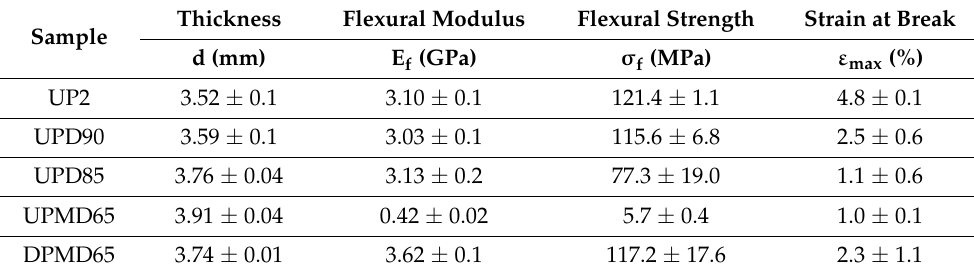
Table 13. Flexural properties of the